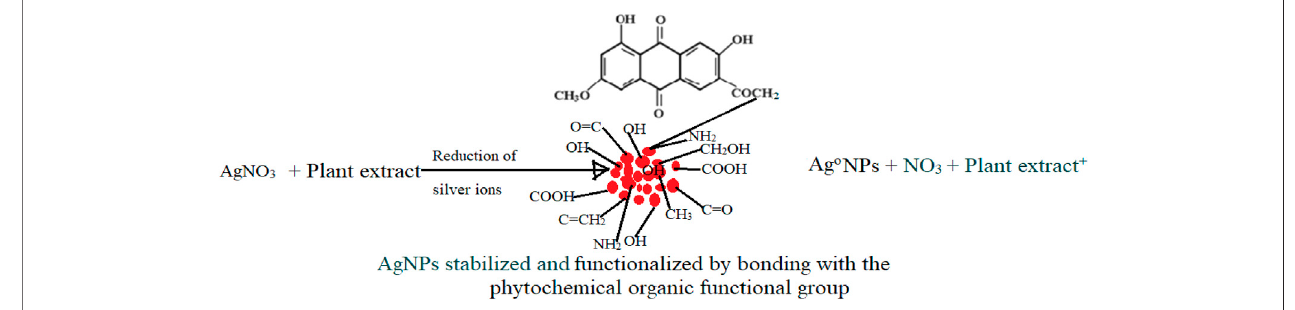
FIGURE 1 | Schematic presentation of the probable mechanism of biosynthesis of silver nanoparticles.